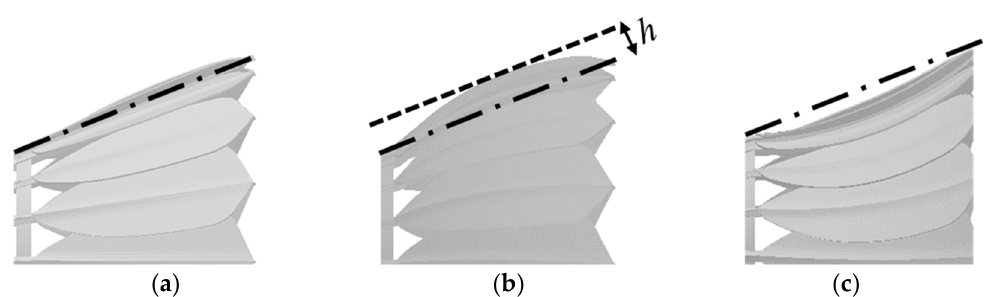
Figure 3. Designed blade. ( a ) Standard, h = 0.0 mm; ( b ) Positive camber, h = 3.6 mm; ( c ) Negative camber, h = −3.6 mm. The dot-dash line denotes the chord line of the